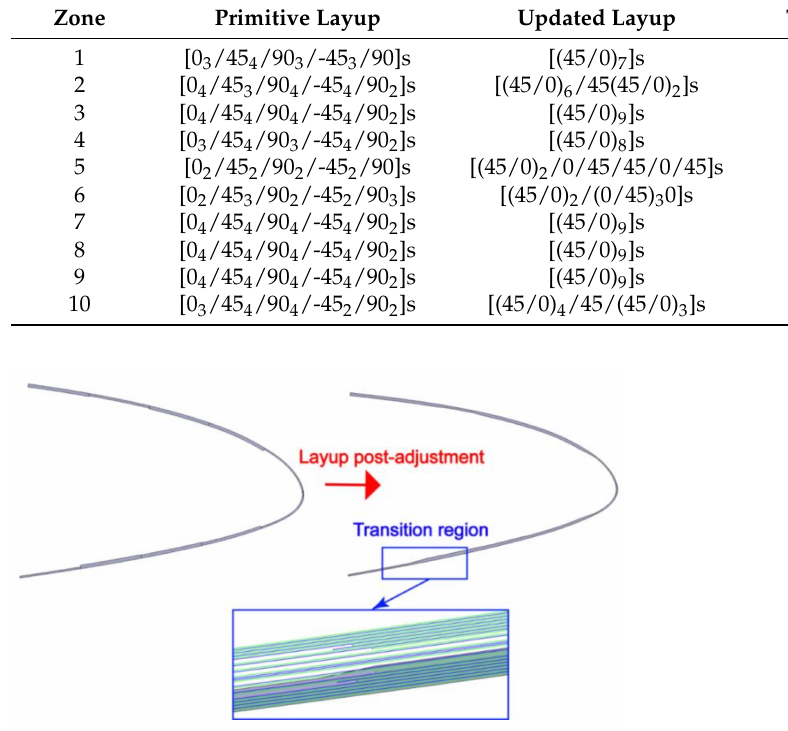
Table 2. Primitive and adjusted layup sequences.